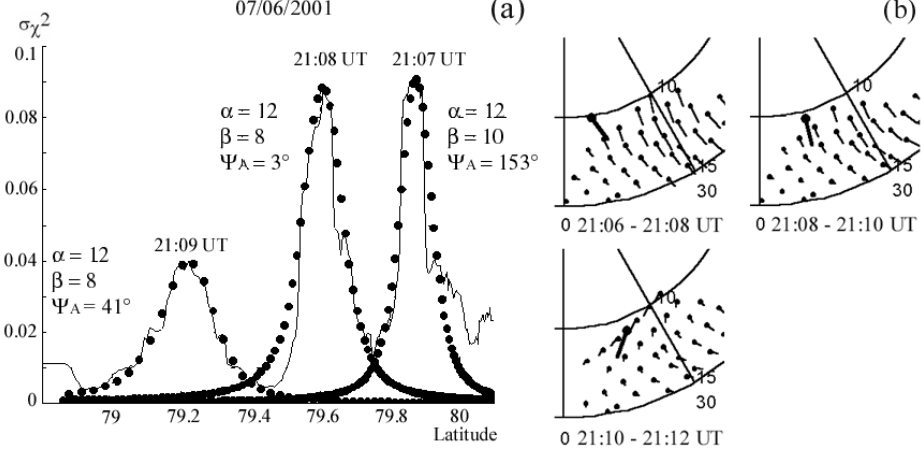
Fig. 2. The same as in Fig. 1 but for the event of 7 June 2001.